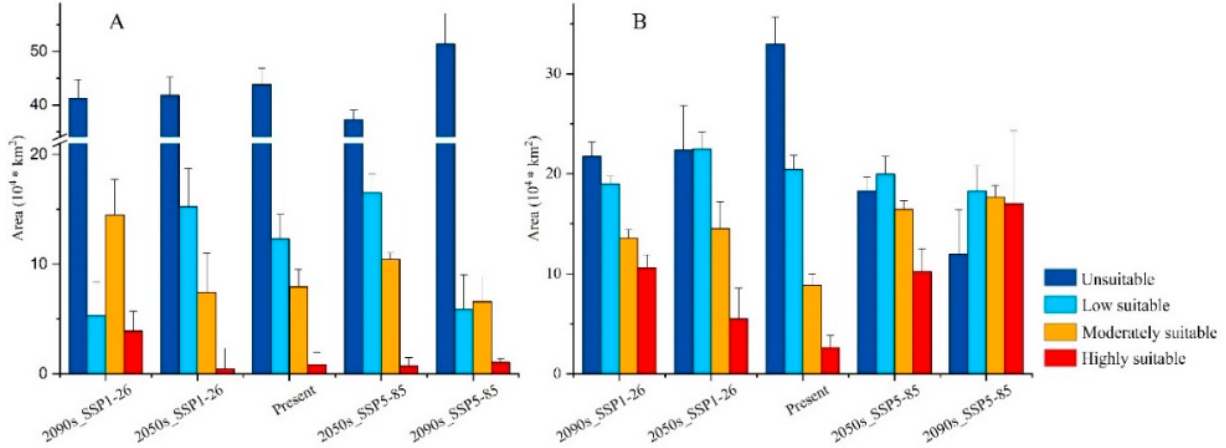
Figure 4. Four suitable habitat areas in the Loess Plateau under different climate scenarios. ( A ) Malus pumilla Mill , ( B ) Prunus ameniaca L.